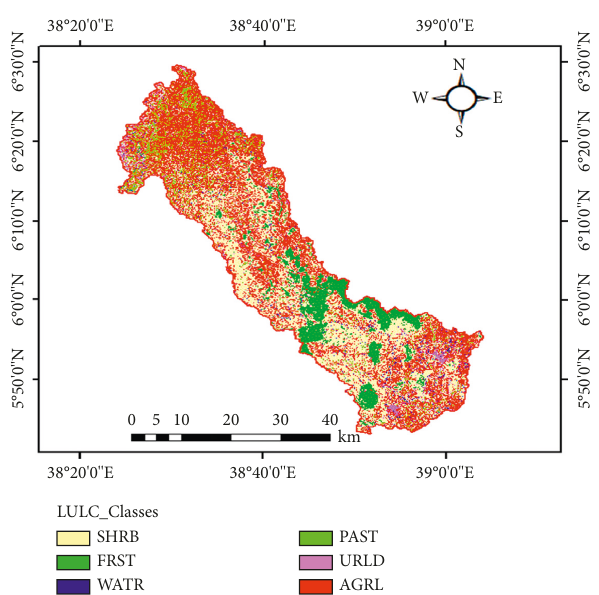
Figure 5: Supervised classification of land use land cover map of the middle Awata watershed.